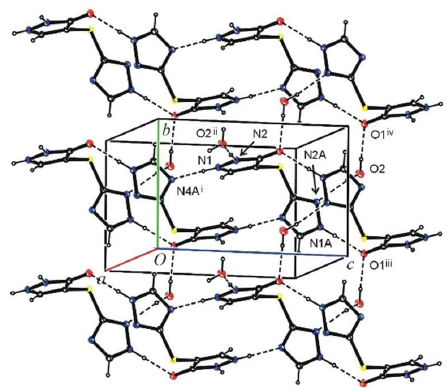
Figure 2. Part of the molecular packing in the crystal 4(A) , showing ( a ) molecules linked by N–H∙∙∙N, N–H∙∙∙O hydrogen bonds and ( b ) the hydrogen bonded (C–H∙∙∙O) sheets parallel to the (10-1) plane. The H atoms not involved in hydrogen bonds have been omitted for clarity.